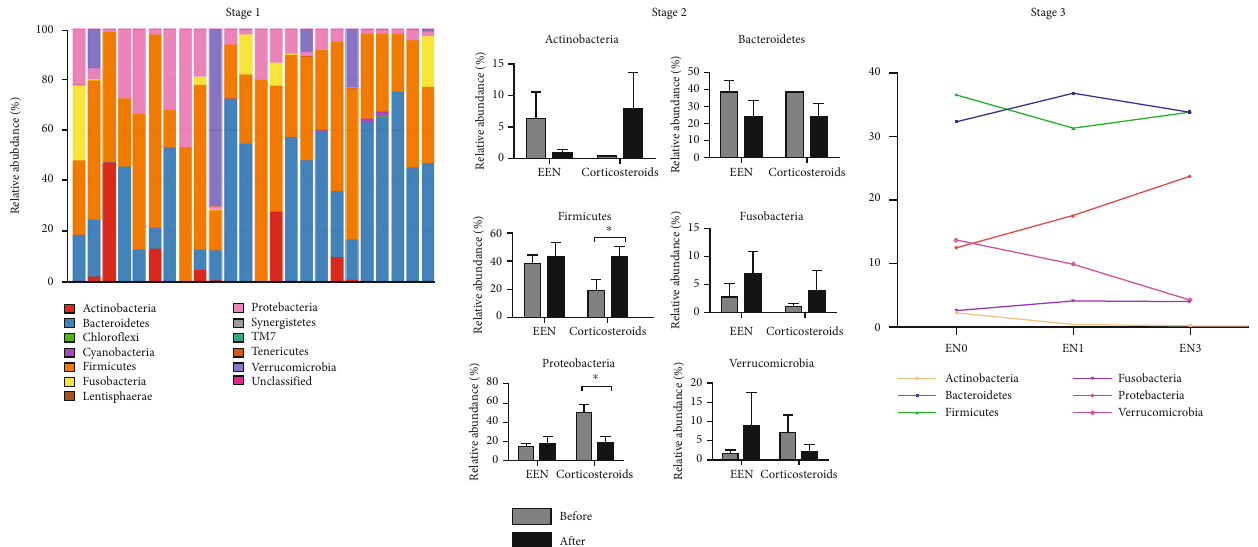
Figure 4: Phyla measurement of the 3 stage. Abbreviations: EN0: 0 month after EEN treatment; EN1: 1 month after EEN treatment; EN3: 3 months after EEN